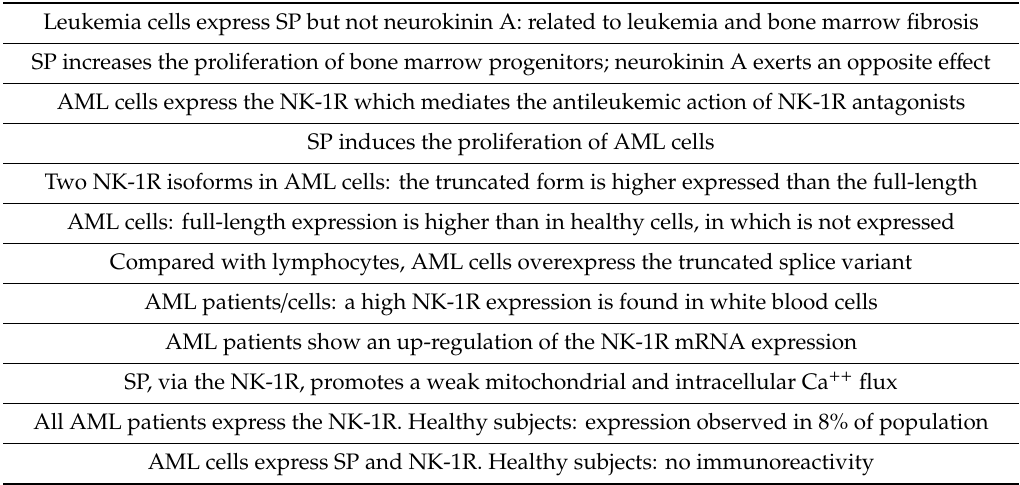
Table 1. The SP / NK-1R system in acute myeloid leukemia (AML) cells. Leukemia cells express SP but not neurokinin A: related to leukemia and bone marrow fibrosis SP increases the proliferation of bone marrow progenitors; neurokinin A exerts an opposite e ff ect AML cells express the NK-1R which mediates the antileukemic action of NK-1R antagonists SP induces the proliferation of AML cells Two NK-1R isoforms in AML cells: the truncated form is higher expressed than the full-length AML cells: full-length expression is higher than in healthy cells, in which is not expressed Compared with lymphocytes, AML cells overexpress the truncated splice variant AML patients / cells: a high NK-1R expression is found in white blood cells AML patients show an up-regulation of the NK-1R mRNA expression SP, via the NK-1R, promotes a weak mitochondrial and intracellular Ca ++ flux All AML patients express the NK-1R. Healthy subjects: expression observed in 8% of